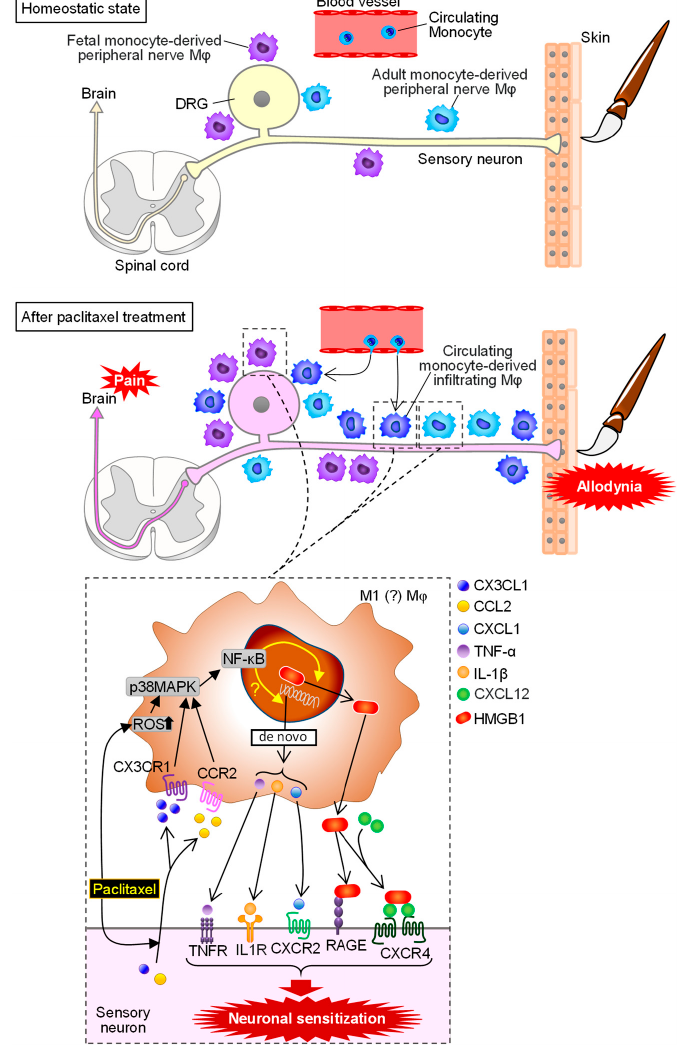
Figure 3. Role of macrophages in chemotherapy-induced peripheral neuropathy (CIPN) caused by paclitaxel treatment. Peripheral nerve macrophages (M φ ), derived from fetal and adult monocytes, self-maintain around the primary afferent. After paclitaxel treatment, macrophages accumulate in the sciatic nerve and DRG through proliferation of peripheral nerve macrophages and infiltration